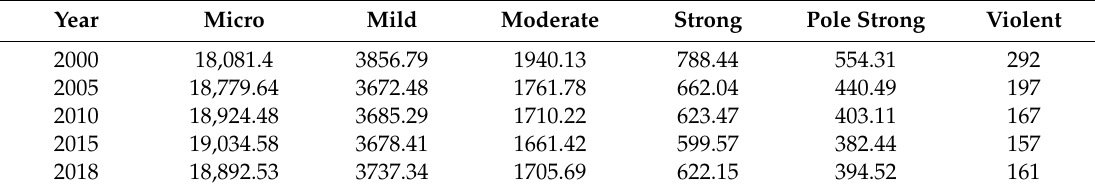
Table 3. Areas of di ff erent soil erosion intensity grades in the Taohe River Basin in 2000, 2005, 2010, 2015 and 2018 (km 2 ).